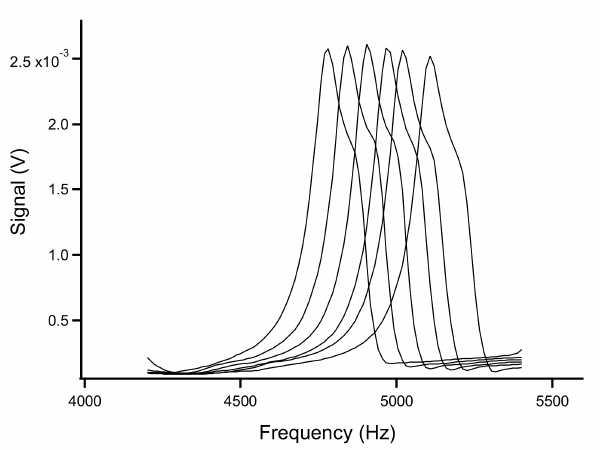
Figure 4. The resonance peak for O 2 /N 2 mixtures. From left to right: 100%, 80%, 60%, 40%, 20%, and 0% oxygen.